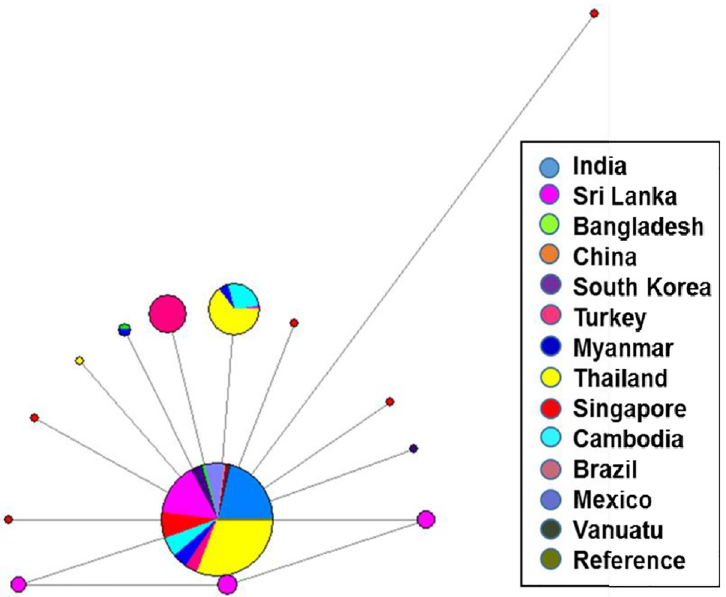
Fig 6. Median-joining network of Pvmsp1 between thirteen geographically diverse populations. Pvmsp1 19 sequences from diverse geographical regions were used to create a median-joining network. This network represents the mutational paths connecting Pvmsp1 19 haplotypes that may explain the observed sequence diversity. Each node represents one haplotype, node size indicates haplotype frequency and node color corresponds to the country of origin. Line length is proportional to genetic